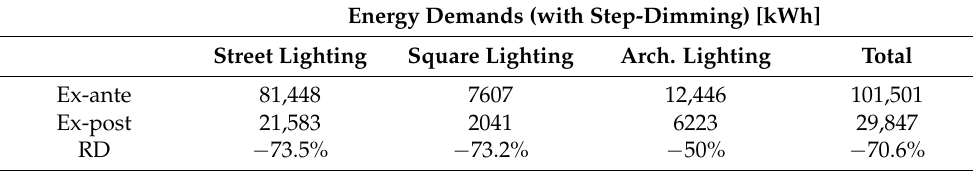
Table 10. Energy demand of the ex-ante and ex-post installations.